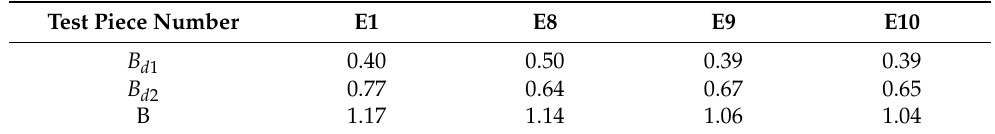
Table 6. Graystone brittleness index